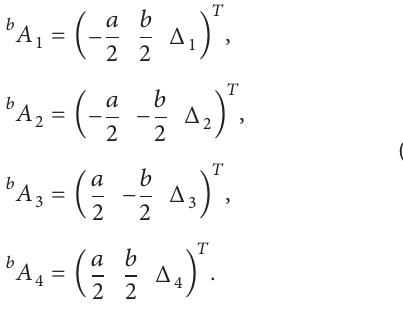
Figure 3: Underwater platform coordinate frame selection.